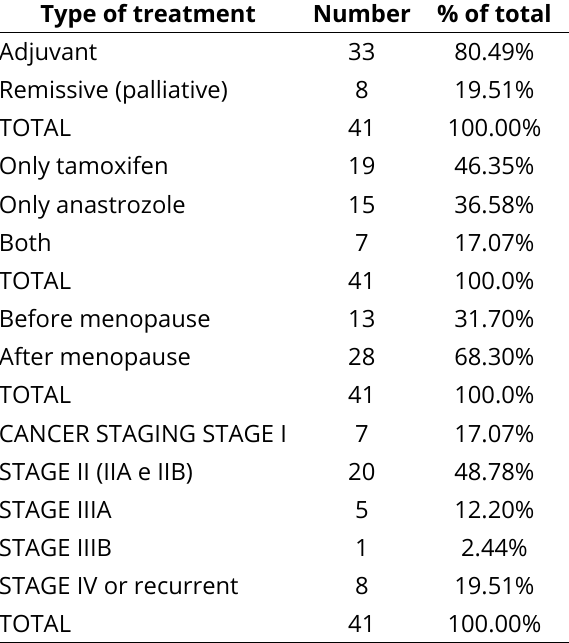
Table 1. Characteristics of the population